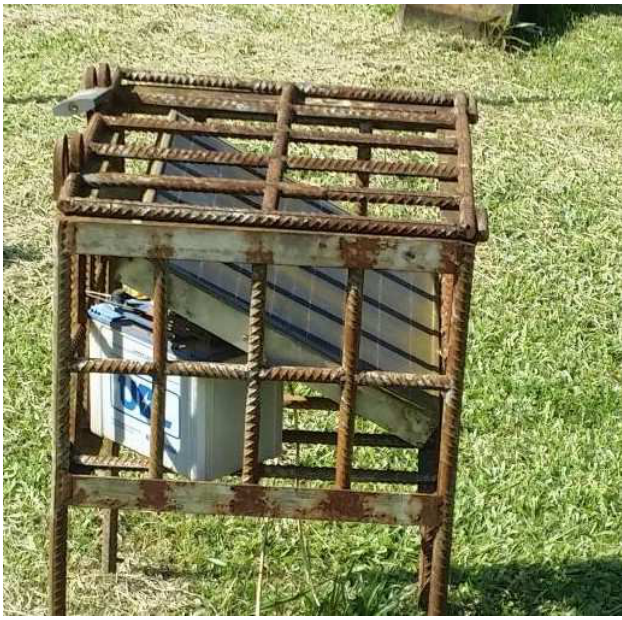
Figure 6 Securing solar panels and batteries using cages is common in East